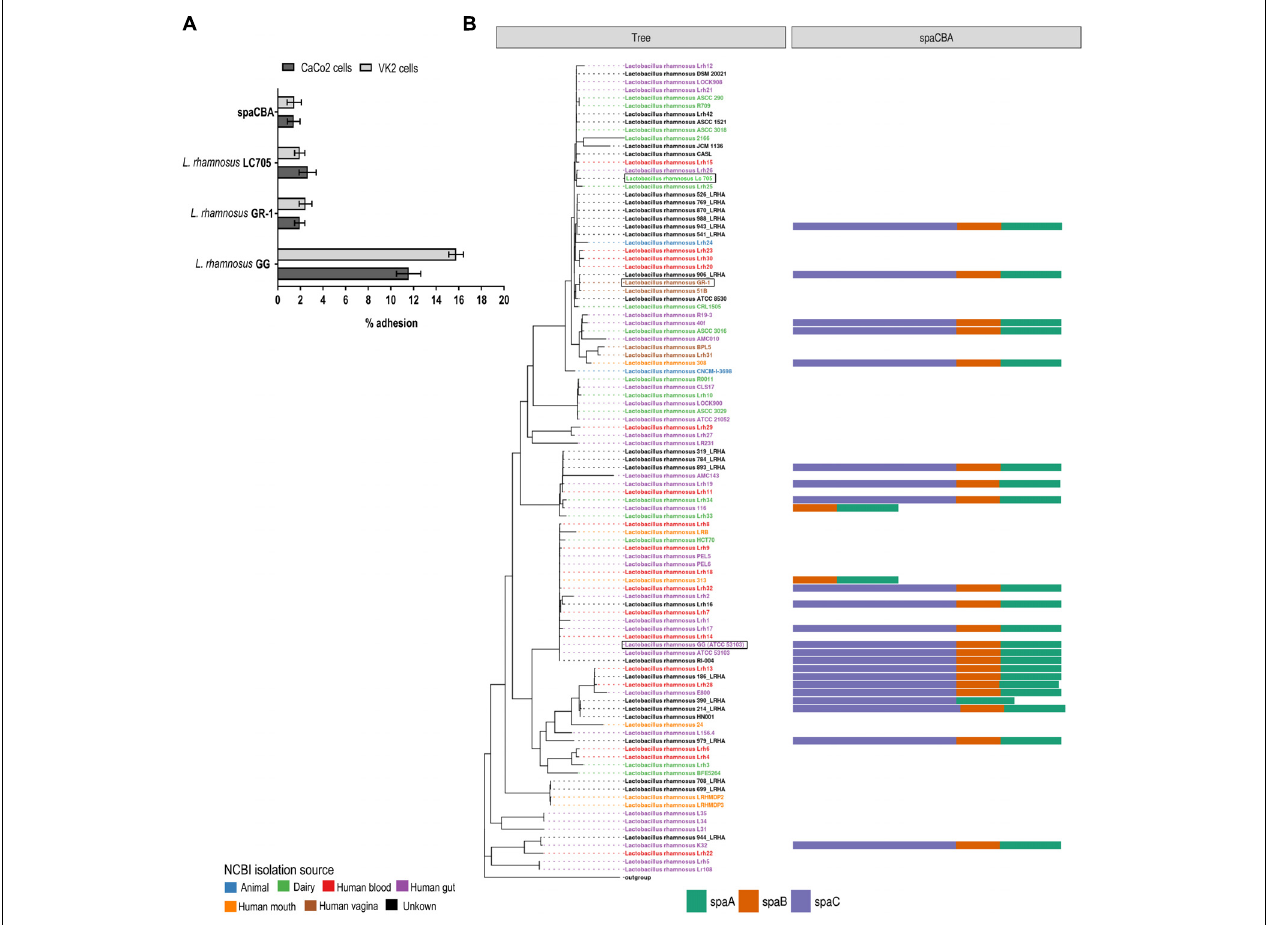
FIGURE 4 | (A) Adhesion to intestinal CaCo2 cells and vaginal VK2 epithelial cells of L. rhamnosus GG, L. rhamnosus GR-1 and L. rhamnosus LC705. (B) Presence of SpaCBA pili-encoding genes in all publicly available L. rhamnosus